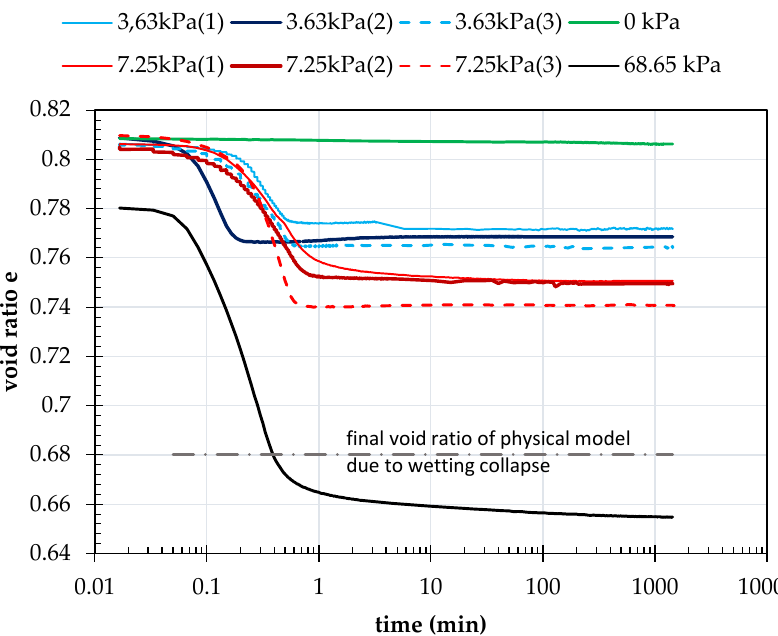
Figure 14. The time reduction of void ratio due to collapse observed during imbibition tests carried out on oedometric specimens of prototype soil at the same initial state condition of the physical model and confined with different vertical stress.